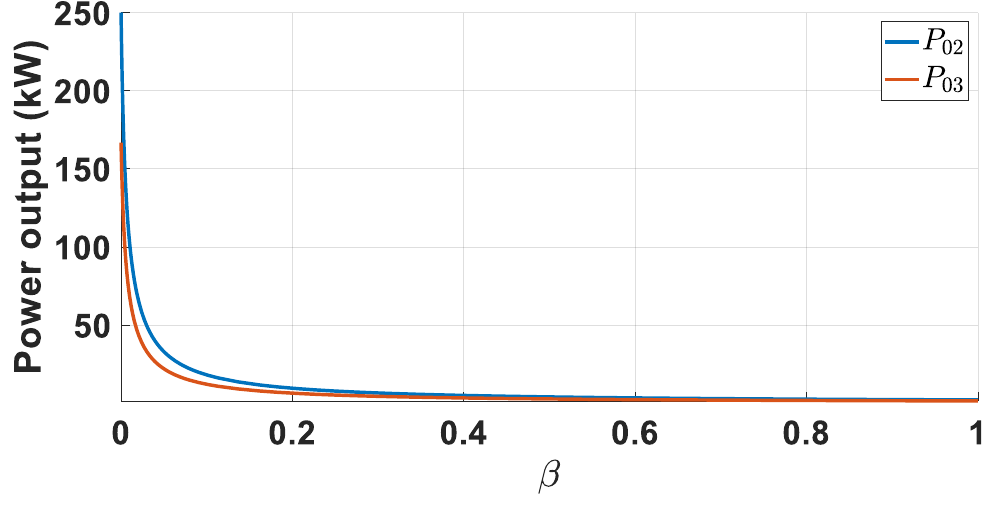
Figure 10. Sensitivity of 𝑃 02 and 𝑃 12 to 𝑉 2 . As the voltage grows to unity and above in each unit, the power transfer increases accordingly. The reason for this is that with the increased line voltage, the line loss between the seller and the load node decreases and more power can thus be transferred to the load node. The nodes which are at the end of a radial distribution system usually get a lower node voltage since there is a higher voltage drop along the lines. Therefore, it is less economic for the seller close to the distribution transformer to sell power to these end nodes and it is thus more optimal for these nodes to purchase power from the adjacent neighbors. In this figure, since supplier 1 is closer to load 2, it sends more power to this load.